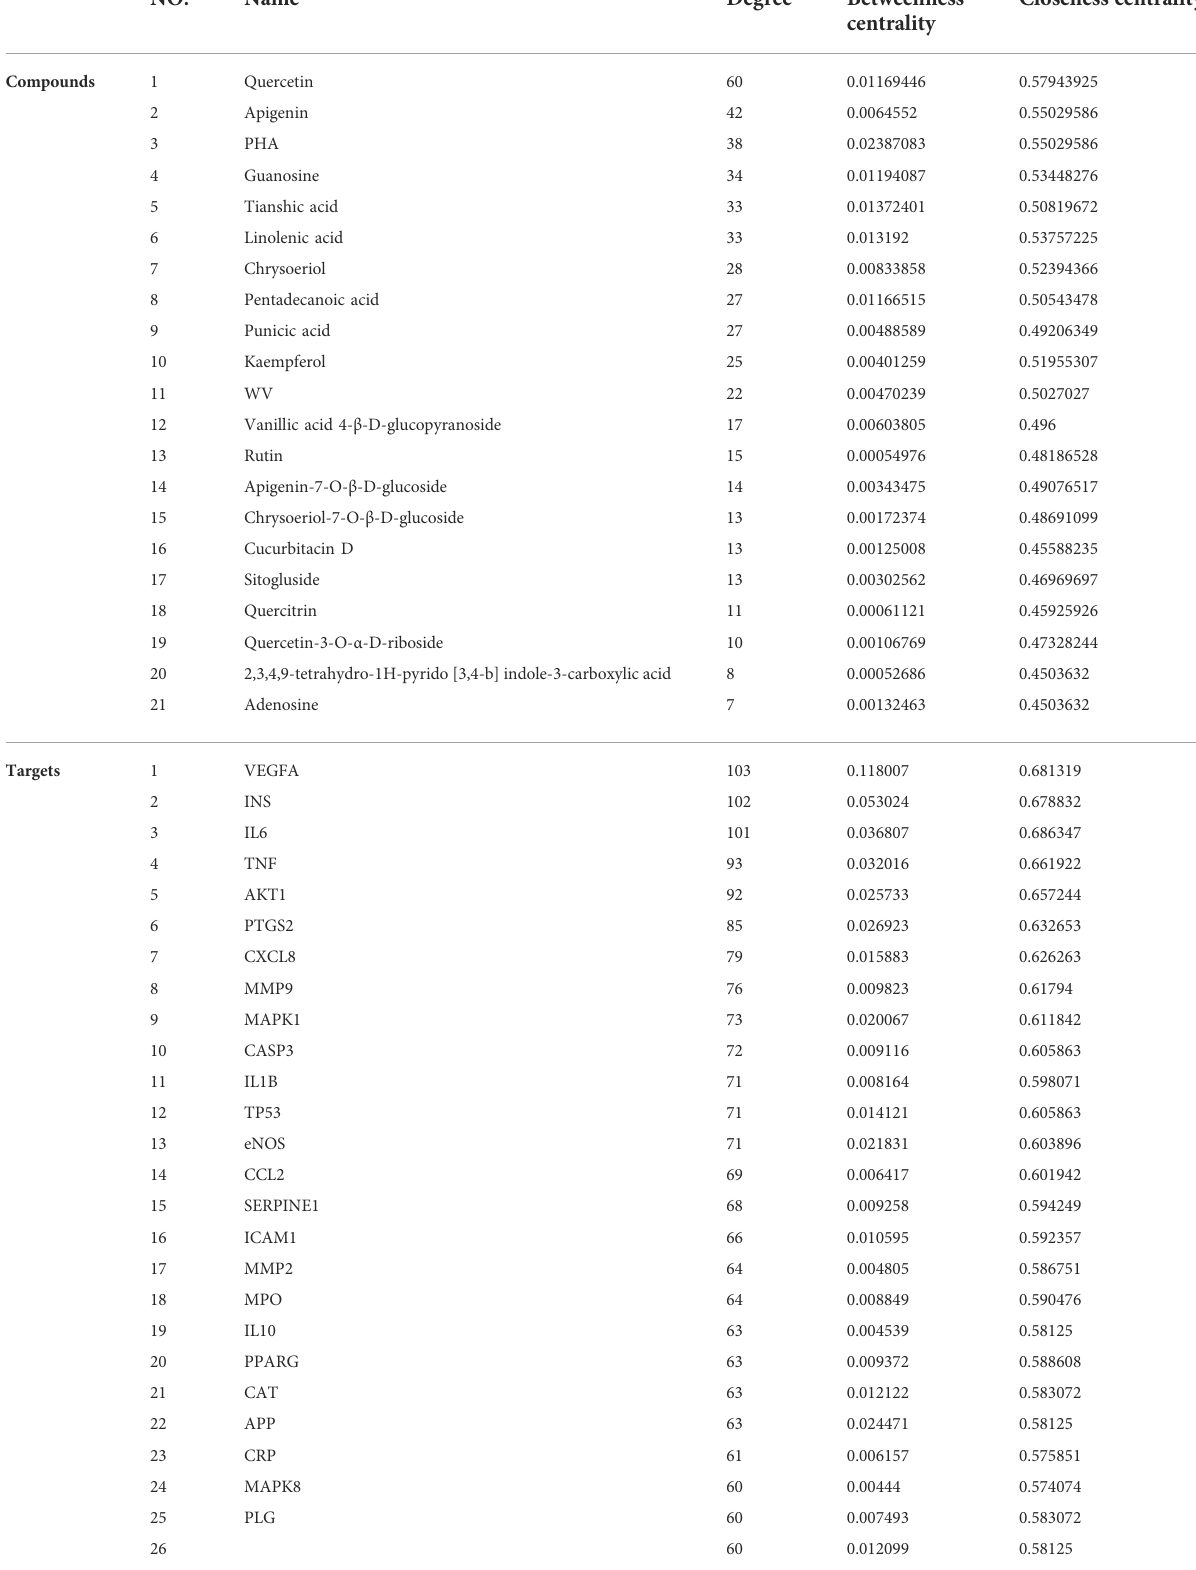
TABLE 2 Topological eigenvalues of the major compounds and